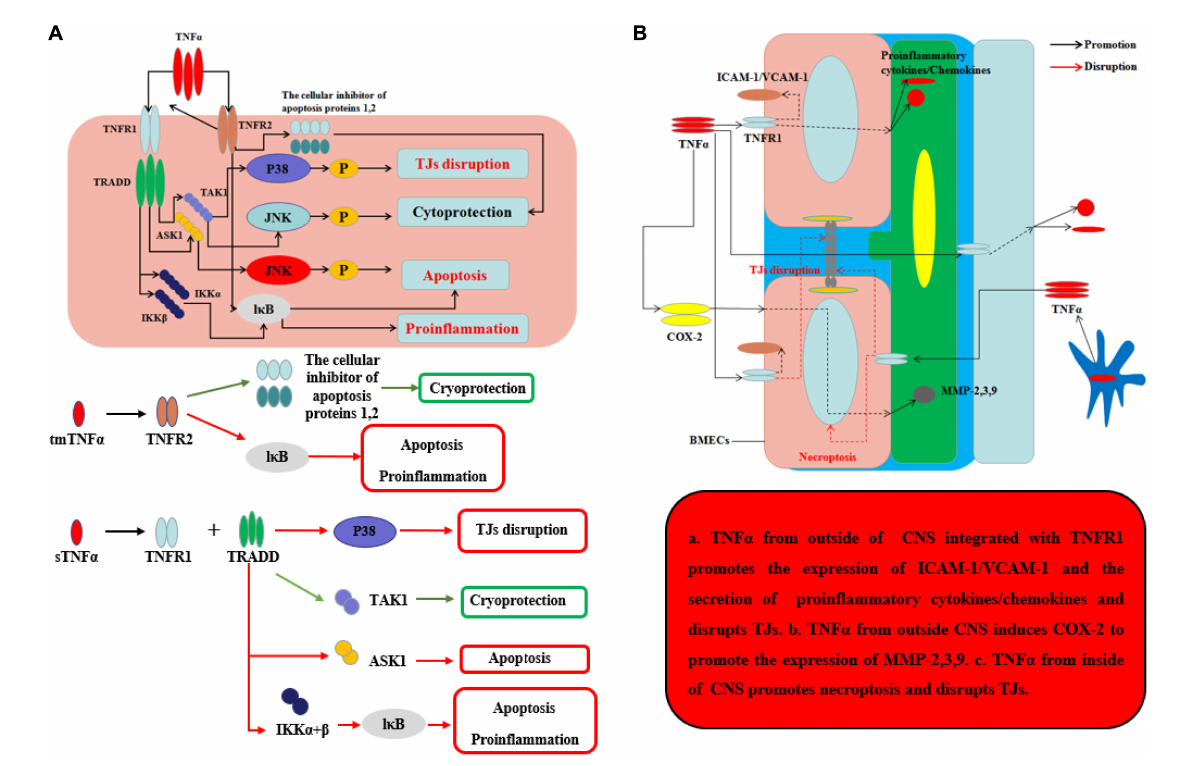
FIGURE3 Effects of TNF α on BBB and neurological degeneration. (A) The mechanism of TNF α on CNS. The tmTNF α integrated with TNFR2 has two functions including promoting the expression of the cellular inhibitor of apoptosis proteins 1,2 to function as cryoprotection and integrating I κ B to induce apoptosis and pro-inflammation. The sTNF α integrated with TNFR1 and TRADD can promote the expression of P38 to disrupt TJs and integrate with IKK α and β and further I κ B to exert apoptosis and pro-inflammation. Moreover, the complex of sTNF α integrated with TNFR1 and TRADD can integrate TAK1 to exert cryoprotection through JNK in early stage, while the complex can integrate ASK1 to exert apoptosis through JNK in late stage. (B) The mechanism of TNF α on BBB from inside and outside of CNS. The sTNF α from outside CNS integrated with TNFR1 promotes the expression of ICAM-1/VCAM-1 on the membrane of BMECs and the secretion of pro-inflammatory cytokines and chemokines, which can disrupt the structure of TJs. Moreover, the complex of sTNF α with TNFR1 from outside CNS induces COX-2 to promote the expression of MMP-2,3,9 which can further disrupt the TJs and basement membrane. TNF α secreted mainly by ACs and microglia from inside CNS promotes necroptosis and disrupts